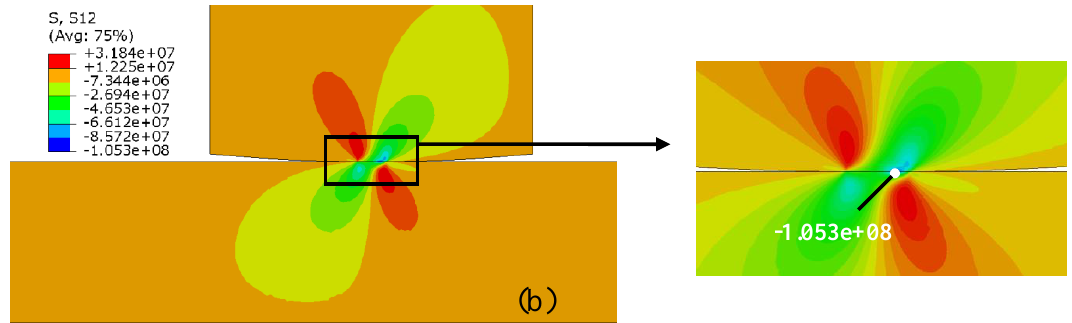
Figure 10. ( a ) Mesh sensitivity diagram (effect of mesh refinement on shear stress distribution on contact interface); ( b ) shear stress distribution near contact interface for homogenous case with 2 μm contact element size.